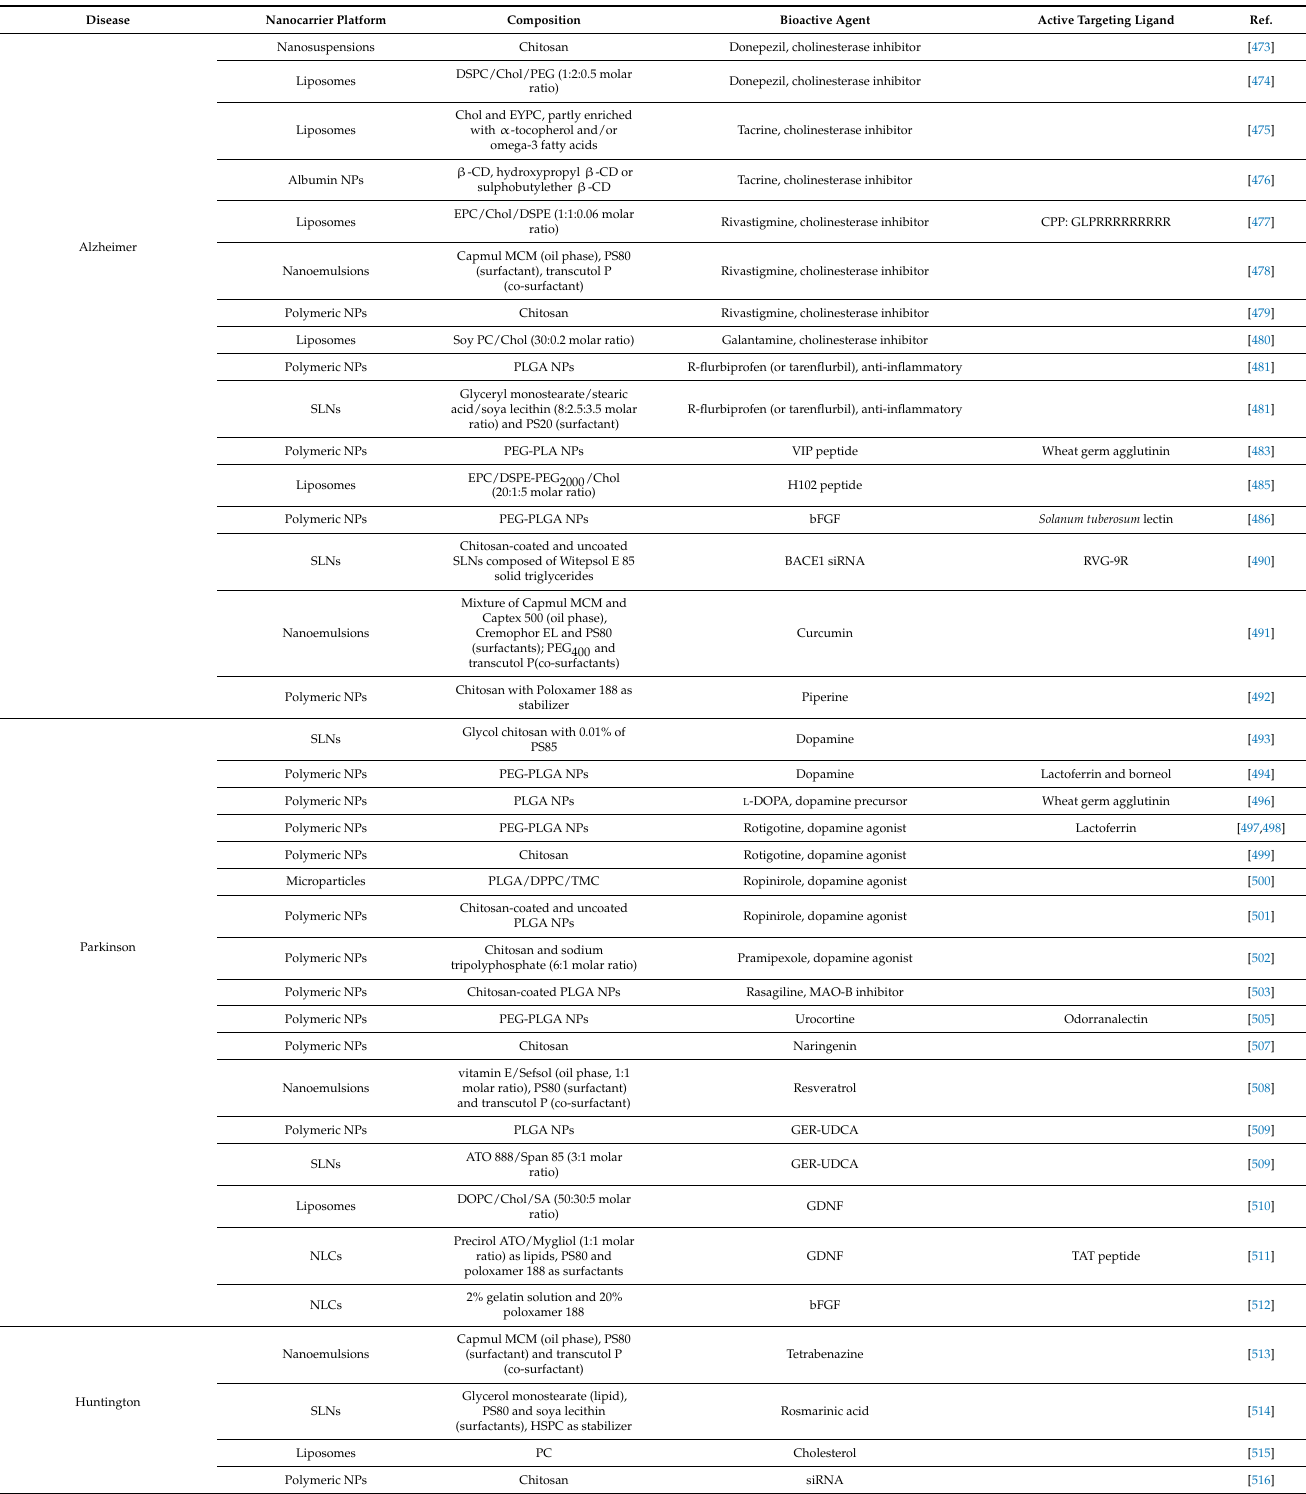
Table 2. Nanosystems for nose-to-brain drug delivery in the treatment of neurodegenerative diseases.